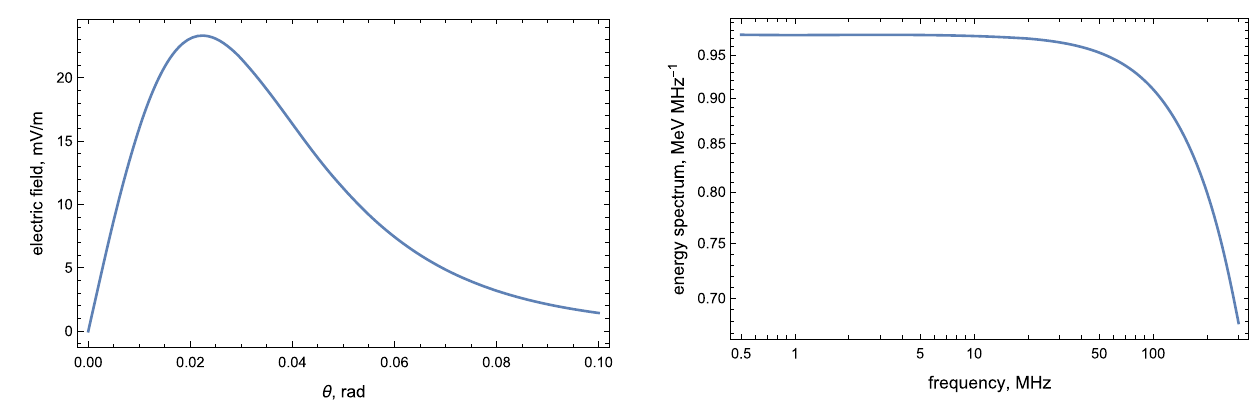
Fig. 2 Strength of electric field (26) induced under thunderstorm ver- sus observation angle θ . The parameters are chosen to be N = 10 9 , γ = 20, E = 1kV / cm